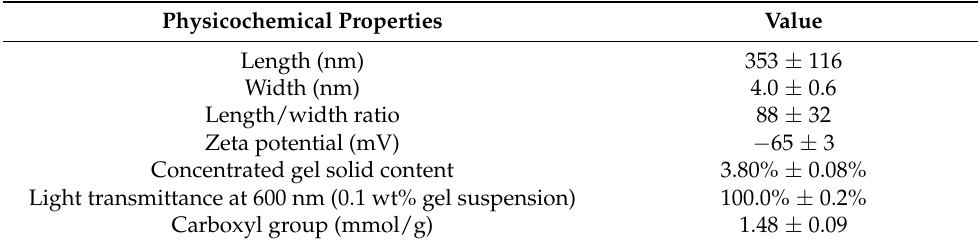
Table 2. Physicochemical properties of